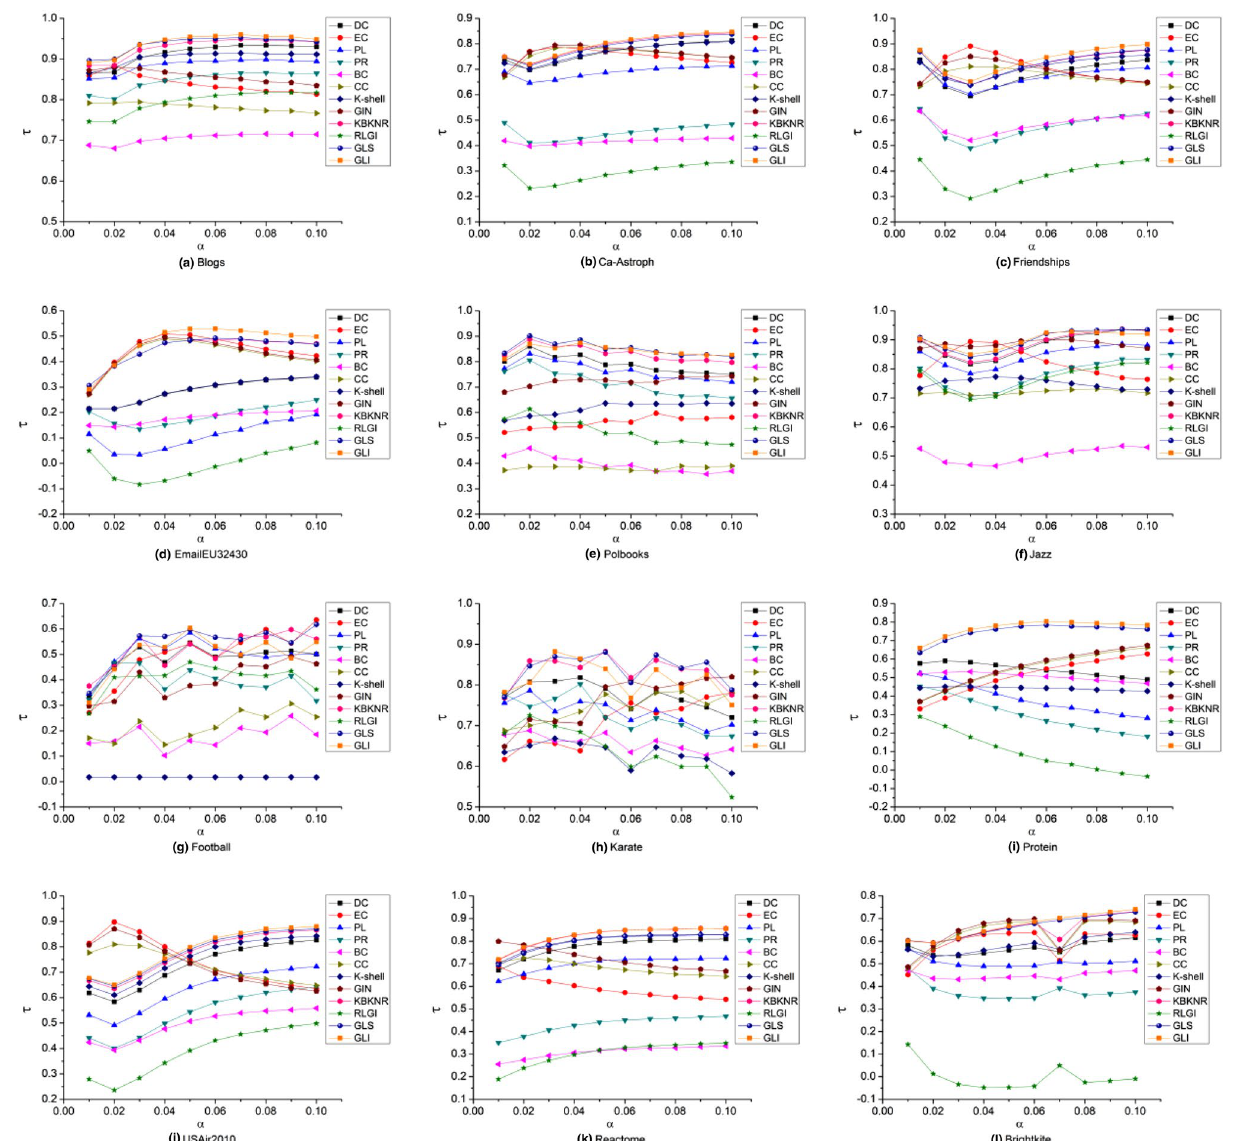
Figure 2. Kendall τ values of different algorithms compared with the SIR model result on 12 networks. Infection probability α varied from 0.01 to